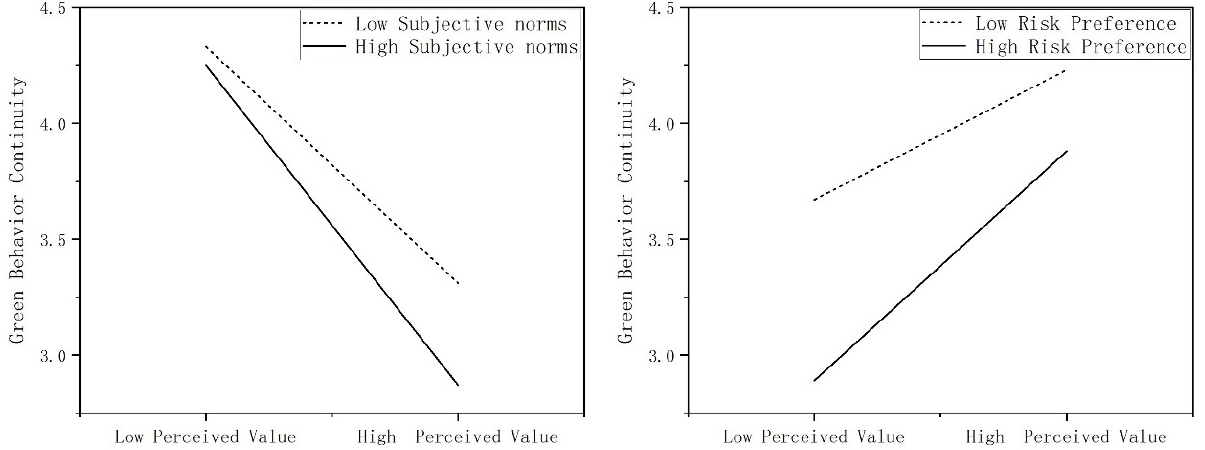
Figure 3. The moderating effect of subject norms (SN) and risk preference (RP) on the relation between perceived value and green production continuity (BC).